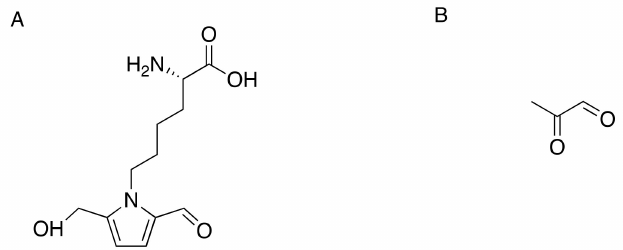
Figure 4. The structures of pyrraline, [2-formyl-5-(hydroxymethyl)pyrrole-1-norleucine] ( A ), and methylglyoxal ( B